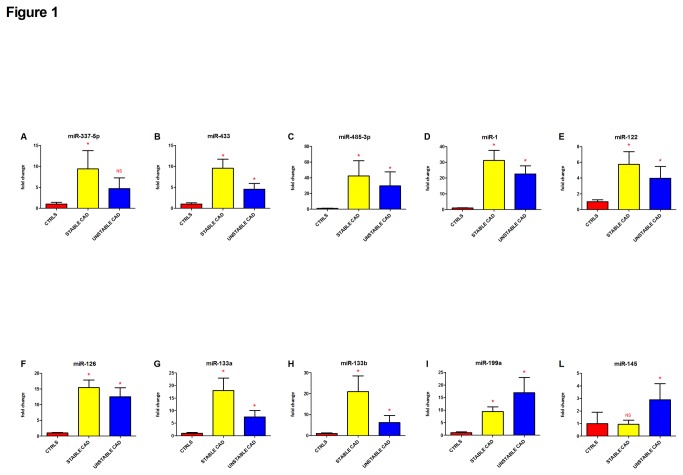
Plasmatic miRNAs regulation by CAD in Stable and Unstable Angina patients.Panels A to L. All investigated miRNAs showed increased expression in CAD subjects, both in SA (yellow bars, 5.7–42.4 fold increase with the exception of miR-145, not regulated) and UA (blue bars, 2.9–29.7 fold increase with the exception of miR-337-5p, not regulated) patients. Values indicate fold changes (expressed as mean ± SEM) of each miRNA vs. its level in control healthy subjects (CTRLS, red bars), arbitrarily set to 1. (*) indicates p≤0.05 vs. control; NS=not significant. Differences among groups were compared using either One-way ANOVA or non-parametric Kruskal-Wallis with Dunn’s post-hoc test, when appropriate.